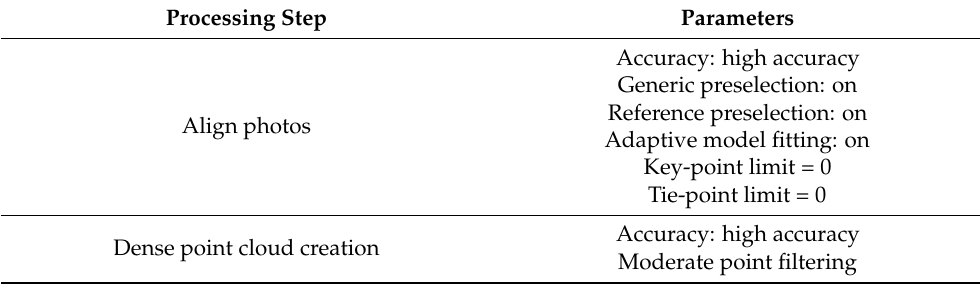
Table 3. Pertinent Agisoft Metashape Pro parameters. Unless specified below, all other values were kept at software